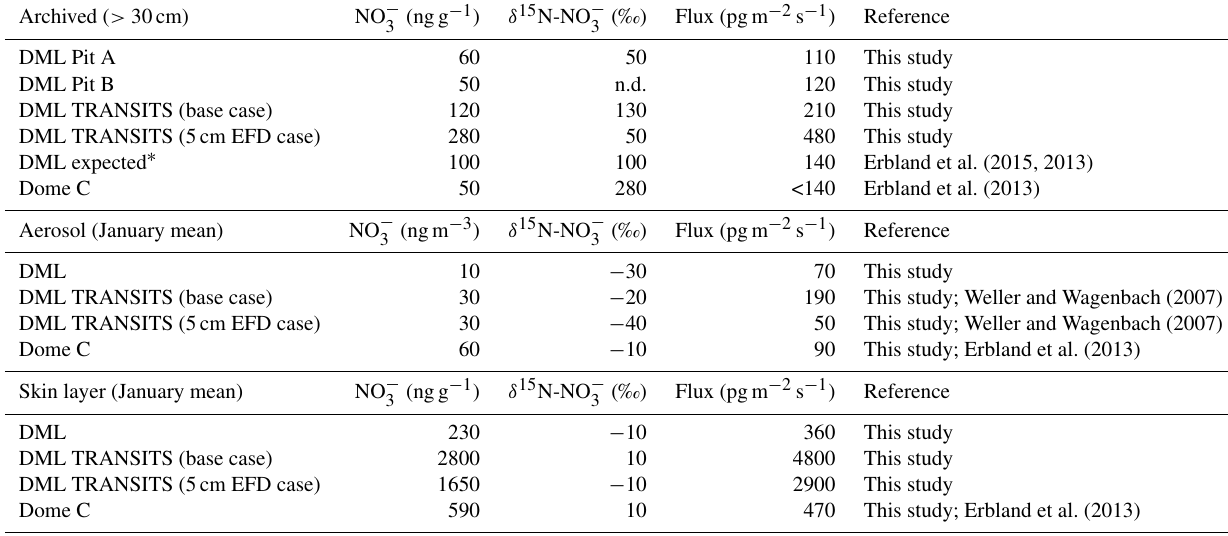
Table 2. Summary of observed and simulated archived, aerosol, and skin layer NO − NO − mass fluxes at Dronning Maud Land (DML) and Dome C. Abbreviation n.d.: no data. Base case refers to the TRANSITS simulation 3 with a snow accumulation rate of 6cmyr − 1 w.e. and an e -folding depth of 10cm, while the 5cm EFD case refers to a TRANSITS